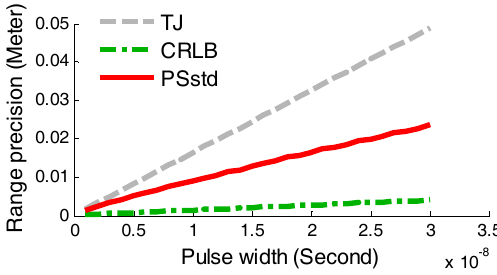
Figure 8. Comparison of PSstd, CRLB and TJ.